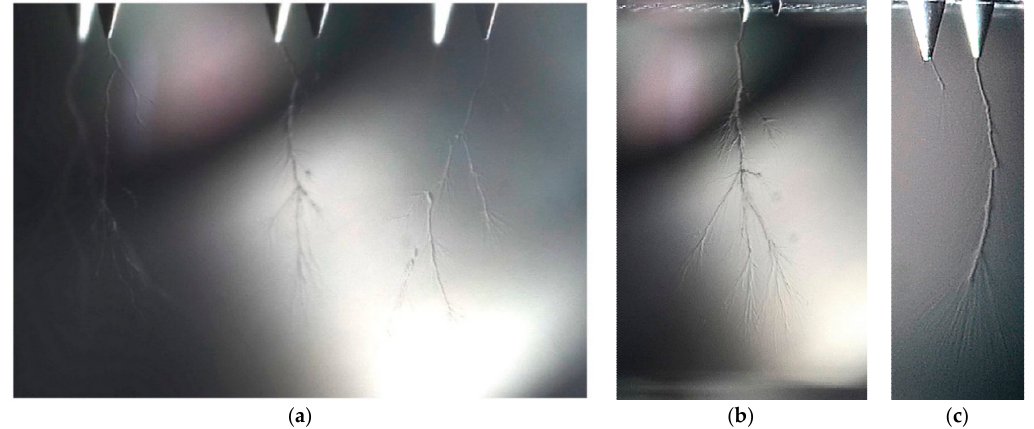
Figure 9. Images of partial discharges and breakdown in SF 6 at 0.4 MPa for ( a ) 2 mm length at positive polarity at 130 kV/cm, ( b ) 0.5 mm length at positive polarity at 188 kV/cm and ( c ) 1 mm length at negative polarity at 187 kV/cm. Note the different length scales of the images, which can be judged by the protrusion lengths.